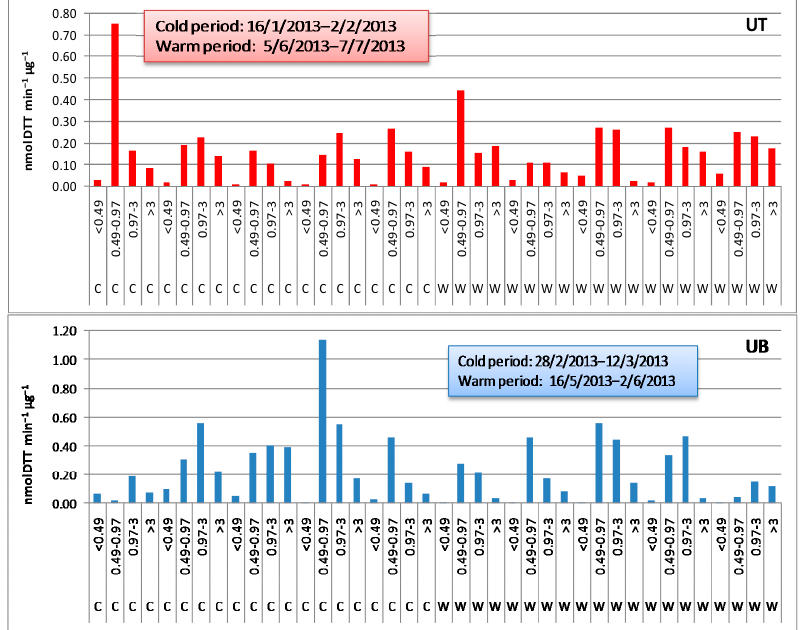
Figure 1. Mass-normalized DTT activity of the various particle size fractions (UT: urban traffic site; UB: urban background site; C: cold period; W: warm period).